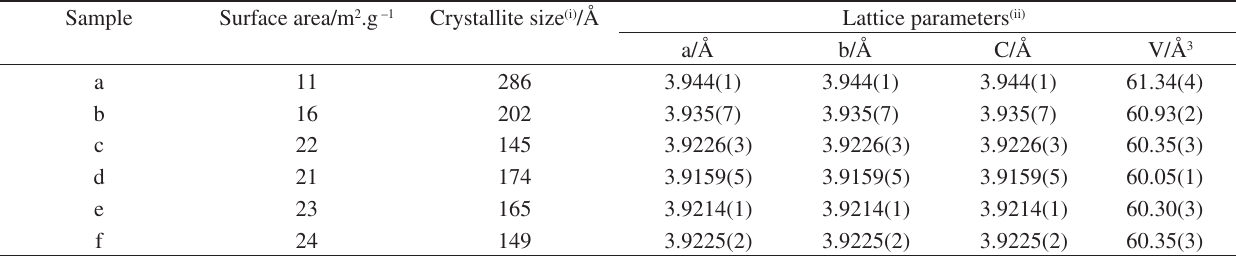
Figure 1. Formation of highly dispersed metallic particles upon reduction of the perovskite precursor dispersed on the surface of Al Table 1. Surface area, average crystallite size and lattice parameter for the synthesized perovskites. Sample